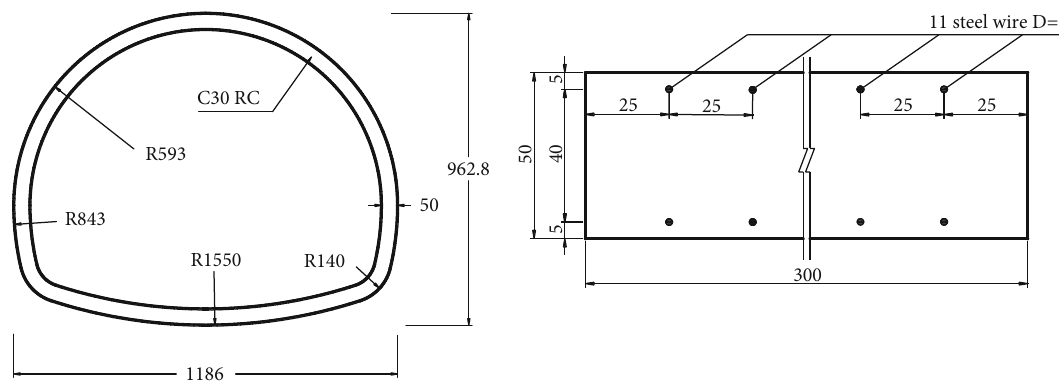
Figure 2: Model design (unit: